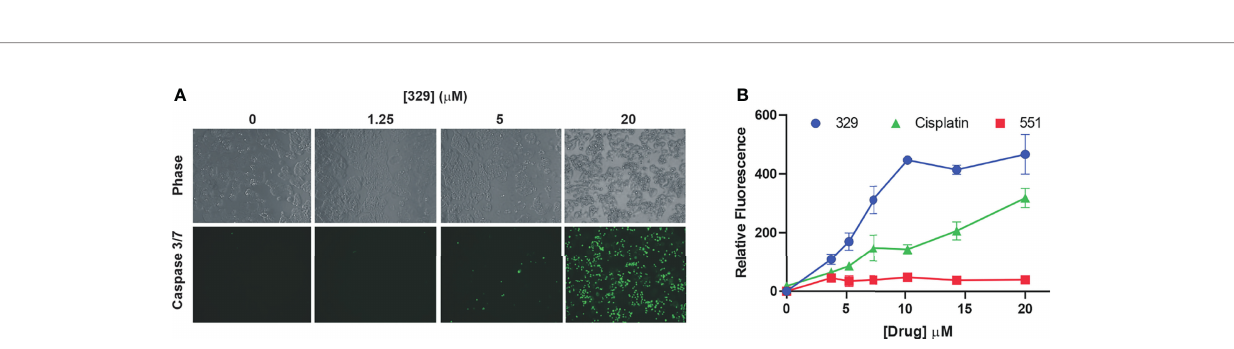
FIGURE 3 | The 329 induction of apoptotic cell death. (A) Analysis of caspase 3/7 activity in H460 cells following 24 h of treatment with 1% DMSO or the indicated concentrations of 329 . Fluorescence images were captured as described in the Materials and Methods . (B) Quanti fi cation of caspase 3/7 activity. Fluorescence was measured in 96-well plates using a Biotek Synergy H1 plate reader following 24-h incubation with the indicated drugs and